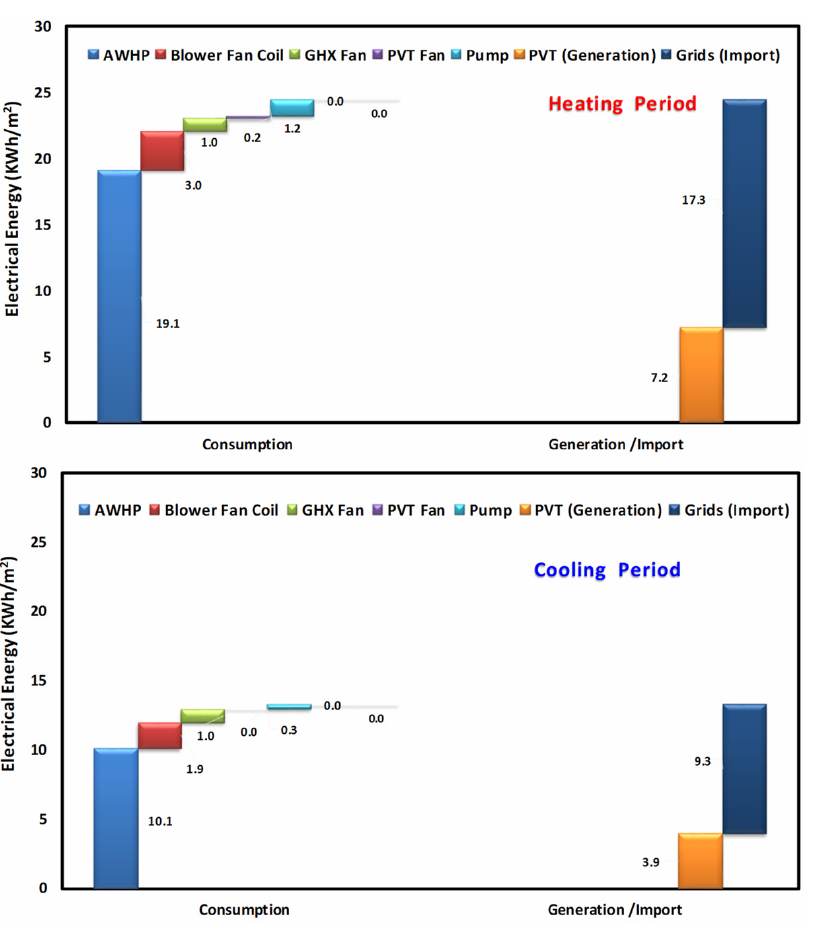
Figure 8. The annual electrical energy of the hybrid trigeneration system under optimum design conditions in heating and cooling periods.